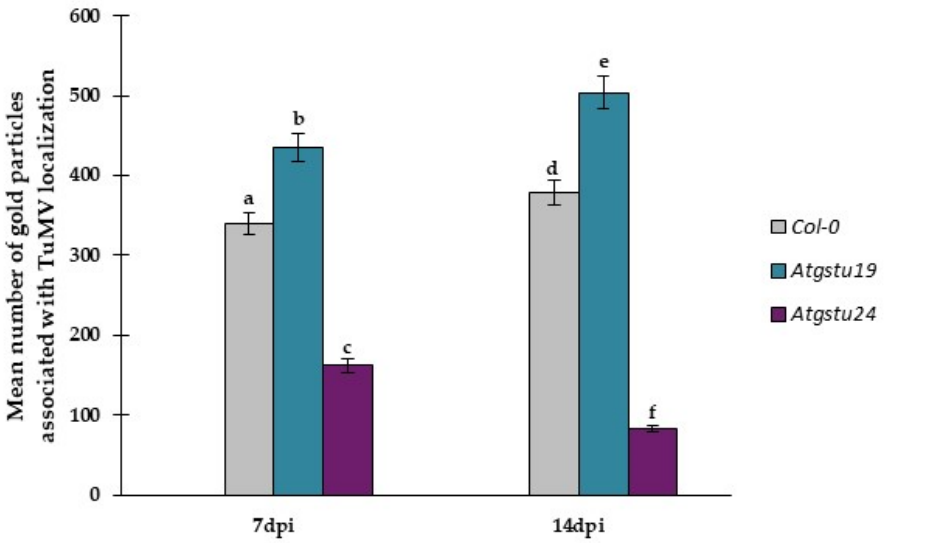
Figure 4. Quantification of gold particles associated with TuMV in Arabidopsis thaliana Col-0, Atgstu19 , and Atgstu24 mutants at 7 and 14 dpi. Significant differences between classes at the p < 0.05 level were assessed by ANOVA with post hoc Tukey’s HSD. Statistically significant values are indicated by letters above chart bars.